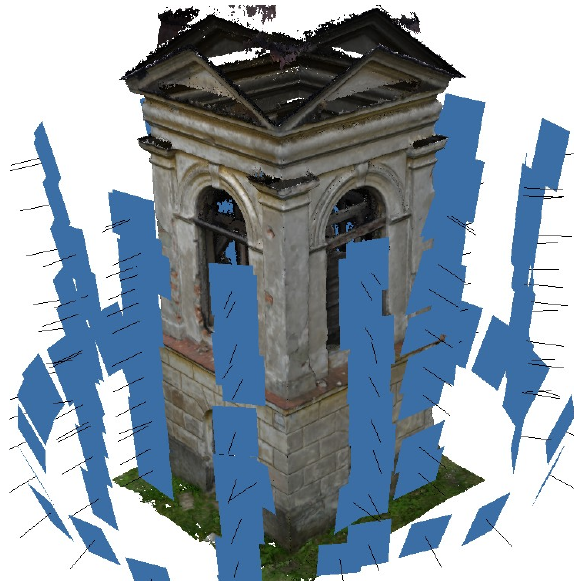
Figure 15. Image configuration using telescopic tripod (PS software)